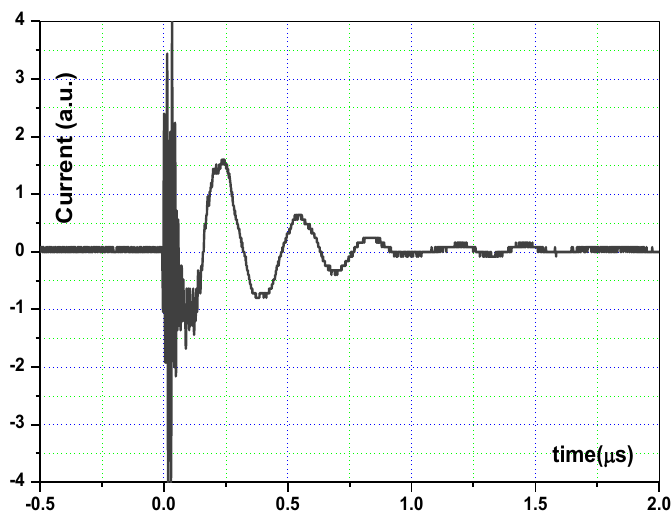
Figure 3. Discharge current signal from IEC